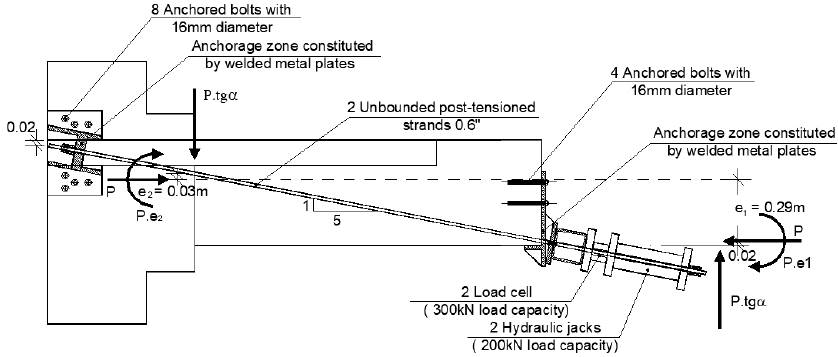
Figure 3. Specimen S3—UFRG jacketing and unbonded strand post-tensioning system.